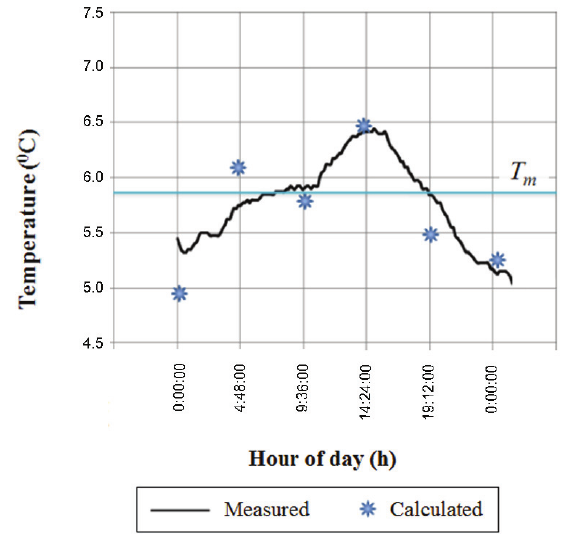
Fig. 5. Comparison of air temperature in the attic (Zender- Swiercz, Piotrowski 2010)